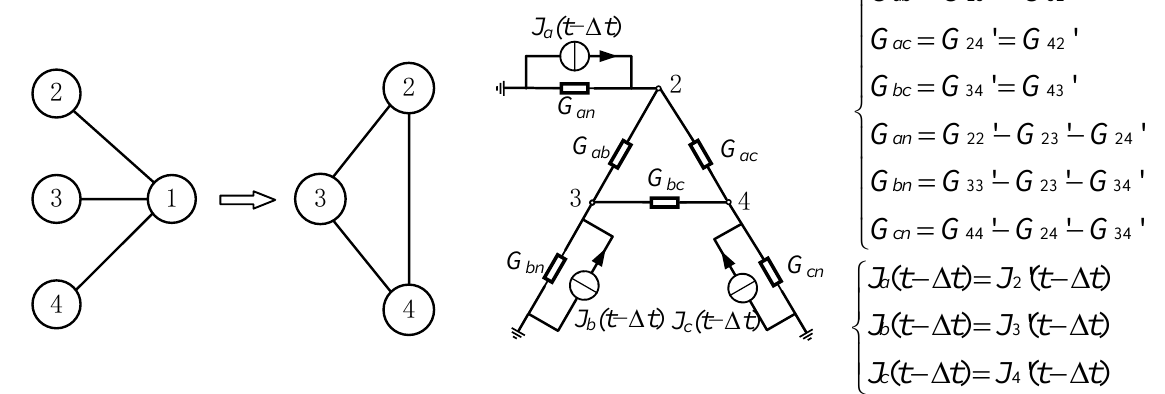
Figure 5. Topological change and equivalent circuit diagram after eliminating internal nodes.